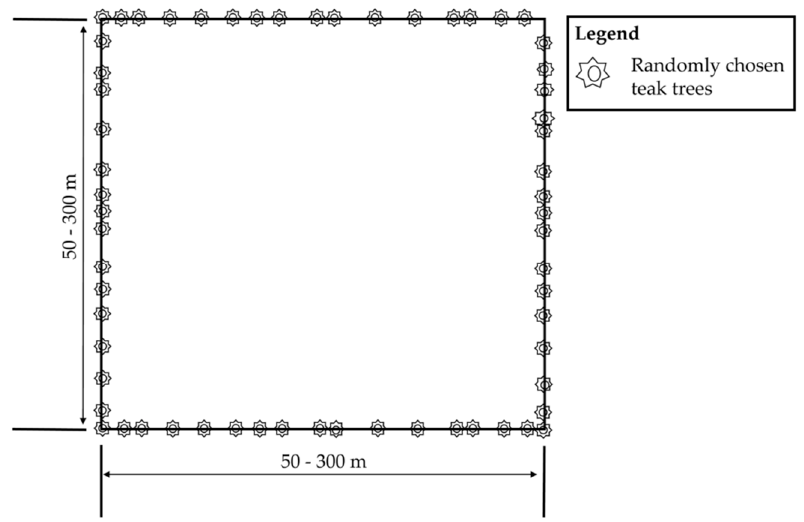
Figure 2. Experimental design of the sampling plots of living fences of teak planted in lines, with a spacing of 2.5 m, and the dominant forage species was Megathyrsus maximus (Jacq.) B. K. Simon & S. W. L. Jacobs in silvopastoral systems (SPS) in the coastal lowlands of Ecuador. Sixty-four teak trees per plot were randomly sampled.